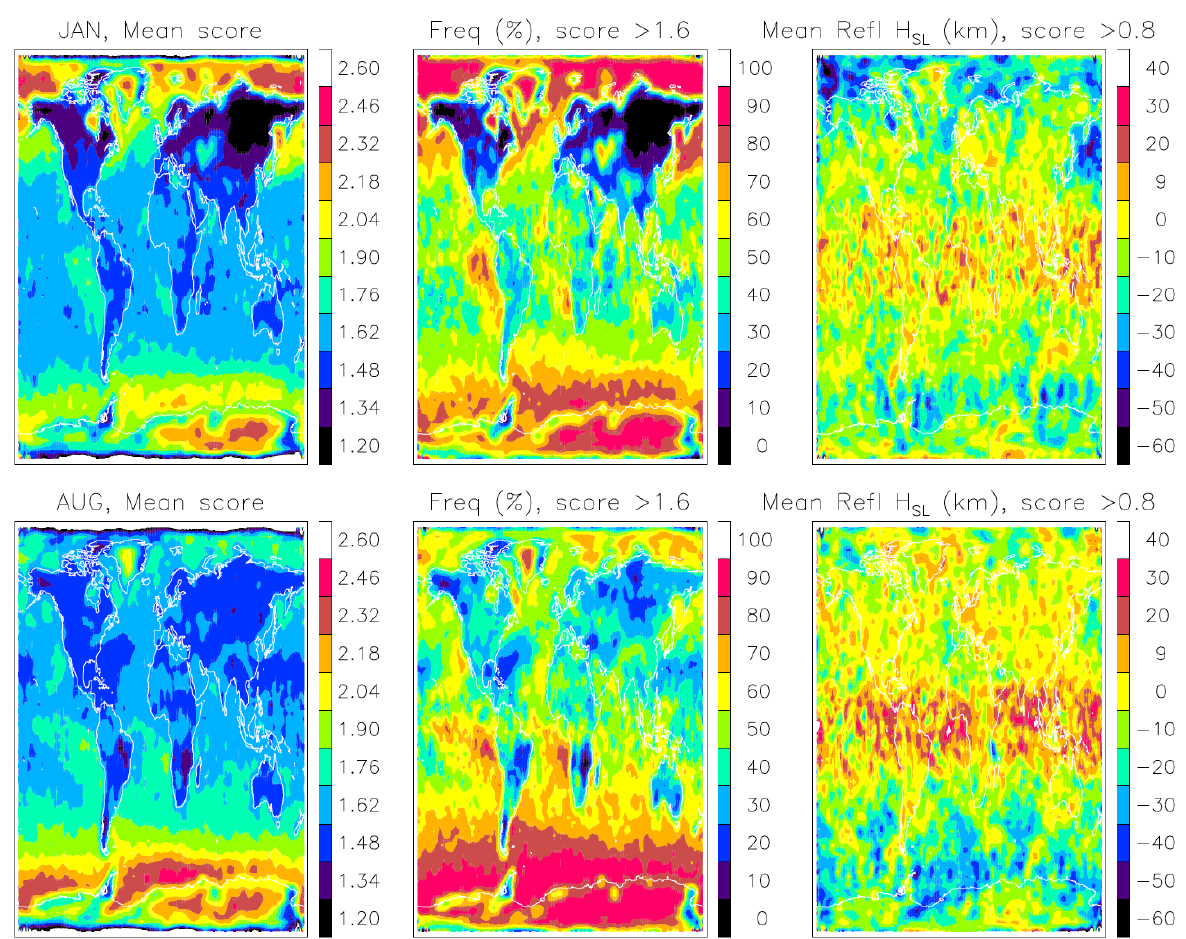
Figure A10. Maps of mean reflection score and occurrence frequency for January and August. Three years (2008, 2009, 2010) of the COSMIC-1 data and a 2° × 2° latitude–longitude grid are used to compile the global statistics.